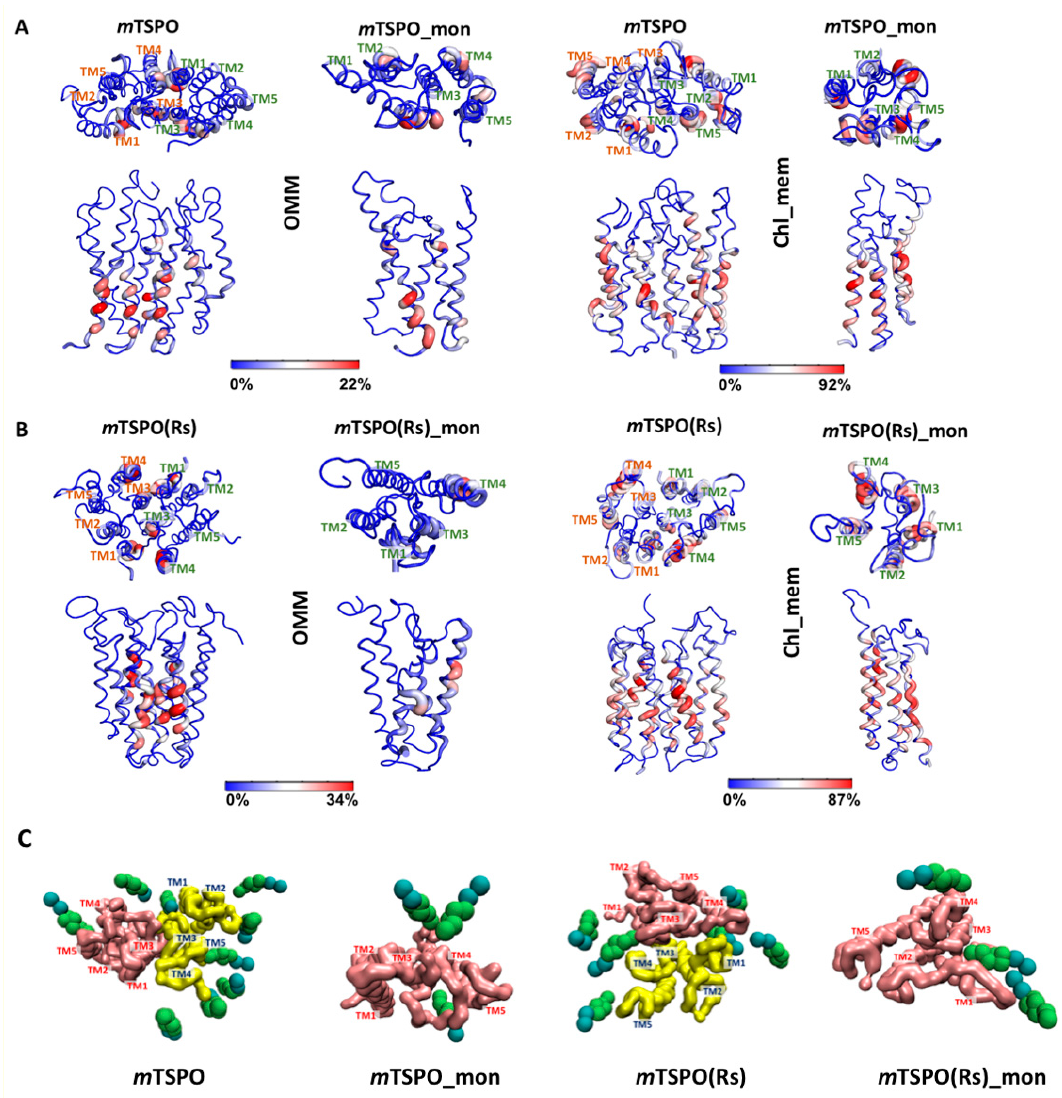
Figure 8. Cholesterol occupancy (i.e., percentage of frames where the lipid is in contact with a given residue (0–100%)) for ( A ) m TSPO, m TSPO_mon and ( B ) m TSPO(Rs), m TSPO(Rs)_mon in both OMM and chl_mem. The analysis was performed on the equilibrated part of the trajectory, that is, the last 6 µ s. Labeling of the helices is done only on the top view of each system for clarity. ( C ) Selected snapshots from our simulations illustrating cholesterol position at the protein surface for m TSPO, m TSPO_mon, m TSPO(Rs) and m TSPO(Rs)_mon in OMM membrane.